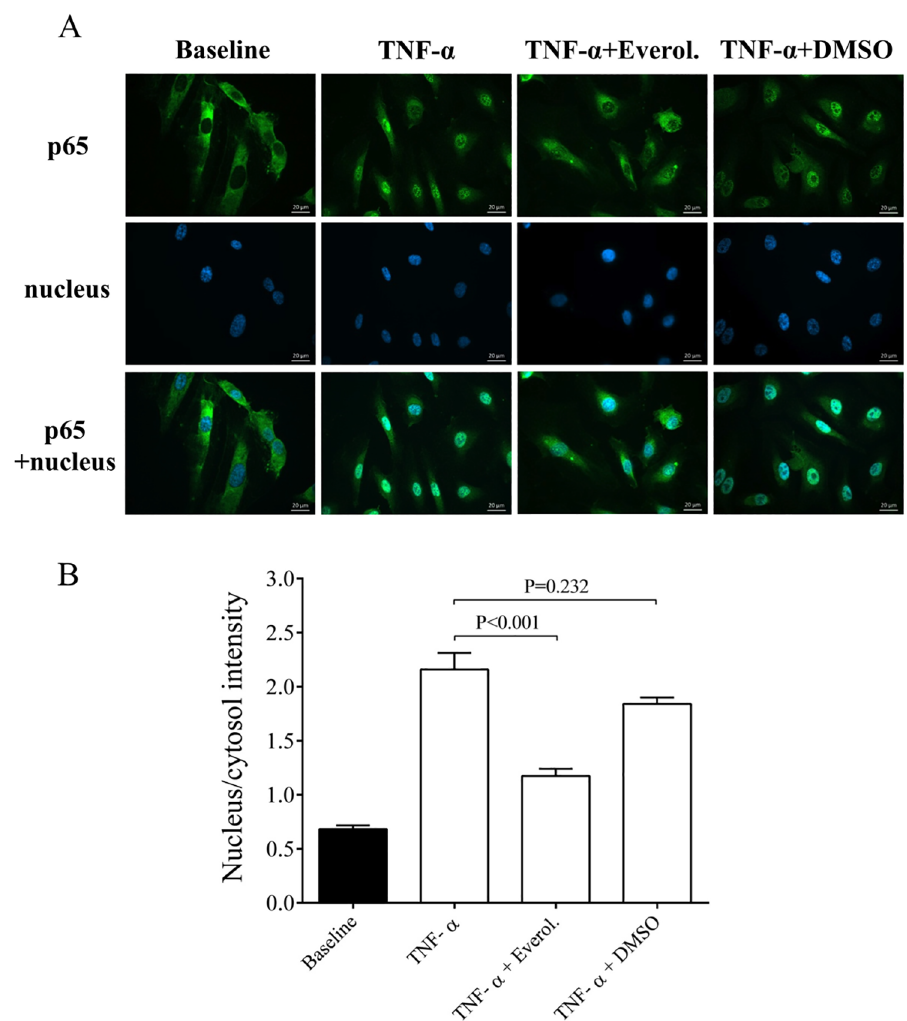
Fig 3. Immunohistochemical staining and analysis of NF- κ B activation in TNF- α and everolimus treated endothelial cells. HCAEC cells were treated for 1 hour with MesoEndo Medium (Baseline), 100 ng/ml TNF- α with or without 0.5 μ M everolimus or cytokine with the solvent of everolimus (TNF- α +DMSO). Nuclear localization of the NF- κ B p65 subunit was monitored by immunostaining. Green: p65 staining; blue: cell nuclei. Scale bar: 20 μ m (A). Ratio of the fluorescence intensity of the NF- κ B immunostaining in cell nuclei and cytosol was analyzed (B). Mean ± SEM, n = 6-8/group.